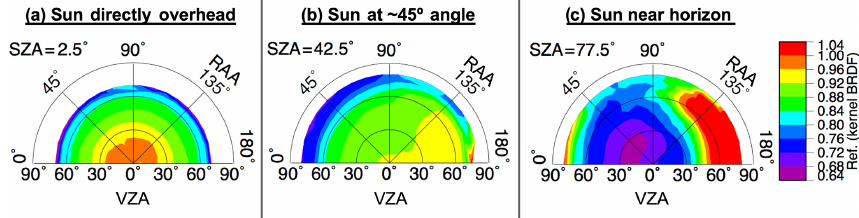
Figure 6. A semiempirical kernel-based BRDF model of anvil top-of-atmosphere reflectance at continuously varying SZA, VZA, and RAA. The coordinate system is the same as that described in Fig.